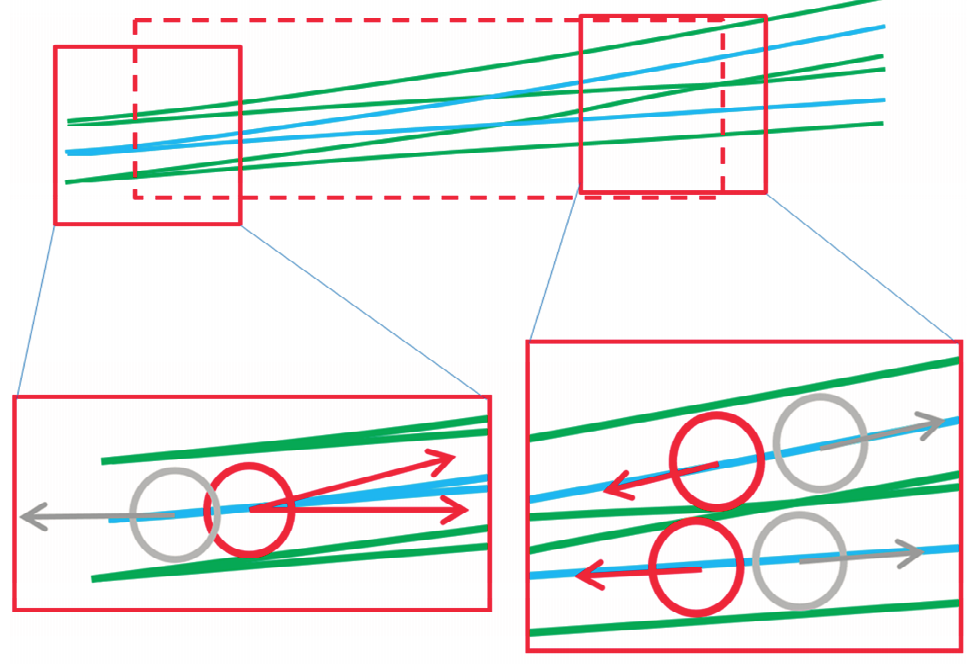
Figure 5. Switch detection (dashed red box) by checking distances between rail track points and center points. Red circles indicate locations where rail track points are closer than e.g., 60 cm to the center points. Grey circles indicate normal situations where center points and track points are more than 60 cm